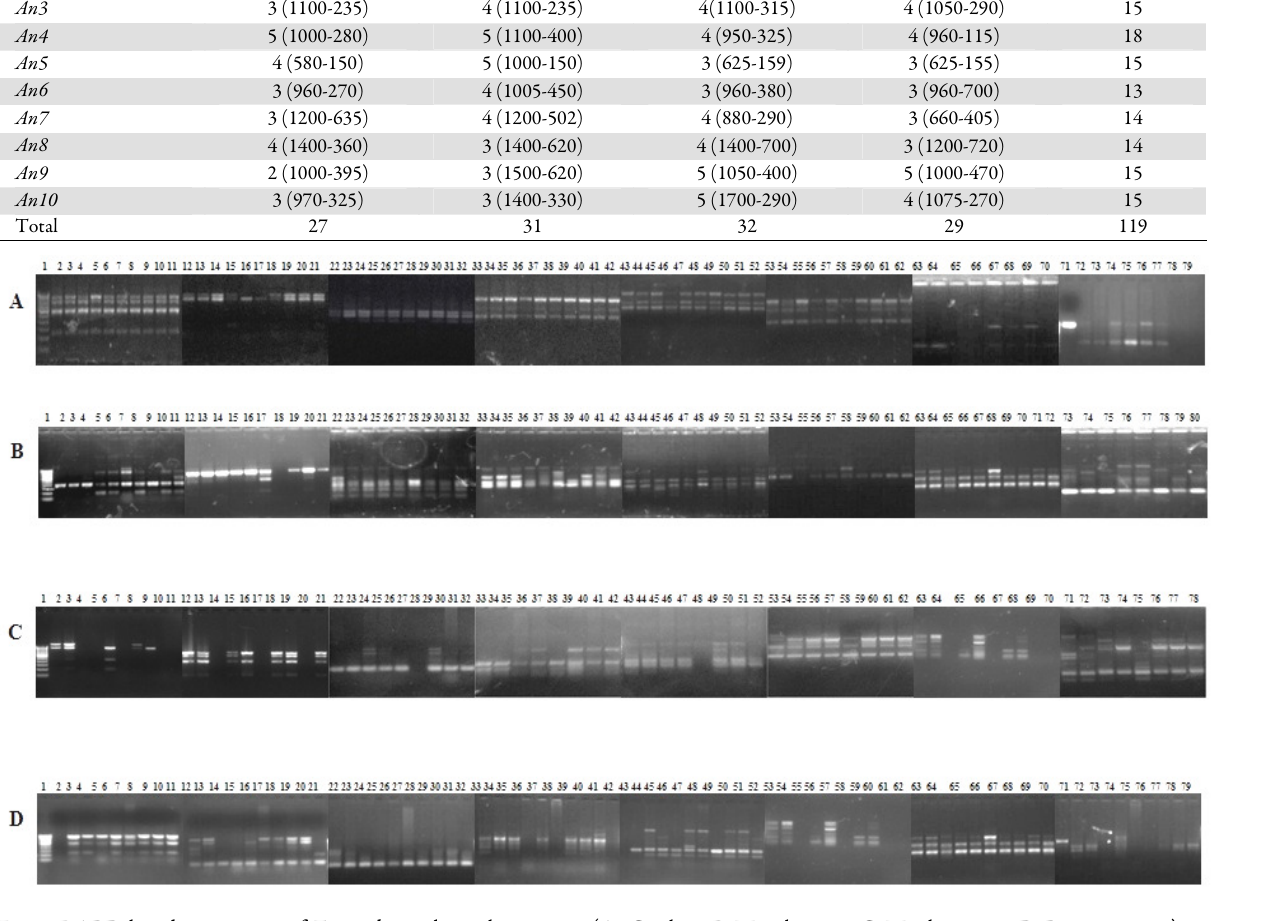
Fig. 2. RAPD banding pattern of E. machnata by eight primers (A- Cochin; B-Marakanam; C-Muthupettai;